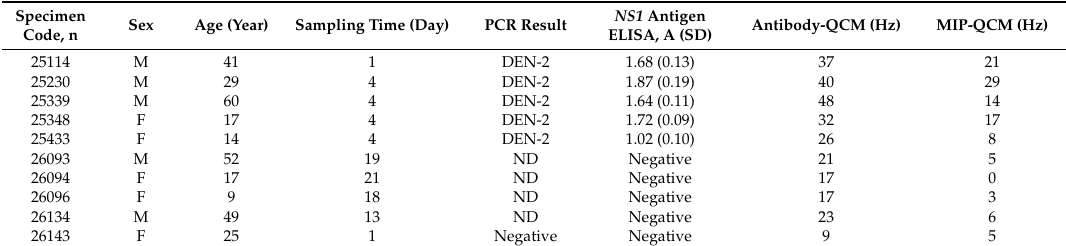
Figure 6. The relative sensor effects of five different sensors designed for monitoring influenza A virus sub-types are shown from ( a – e ). It is evident that each MIP layer showed the highest sensor response to the virus that was used as template during imprinting; ( f ) shows the reproducibility studies as a sensor signal of two MIP layers imprinted with the same virus sub-type and compared, the R 2 value was 0.99 and standard error was found 3.1% for 50 measurements, reproduced with permission from [88]. Table 3. Comparison of MIP-QCM sensor data with antibody-QCM, PCR and NS1 antigen ELISA results for detection of dengue virus infections in clinical samples. ND indicates not detectable, reproduced with permission from [119].